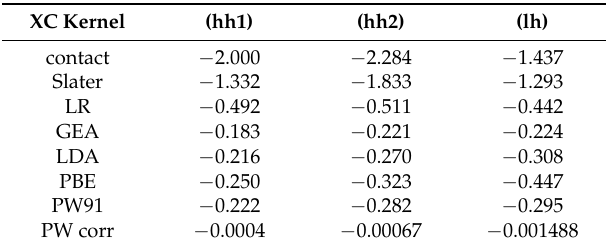
Table 1. Excitonic energies (in meV) for different hole states in GaAs obtained with different XC kernels. Here and in Table 2, if not specified we use the following parameters for the local and LR kernels: A = 1,ε = 1 . The experimental values for the exciton binding energies are 1.51–4.9 meV (the heavy-hole energy is larger, around 5 meV) [45,46].